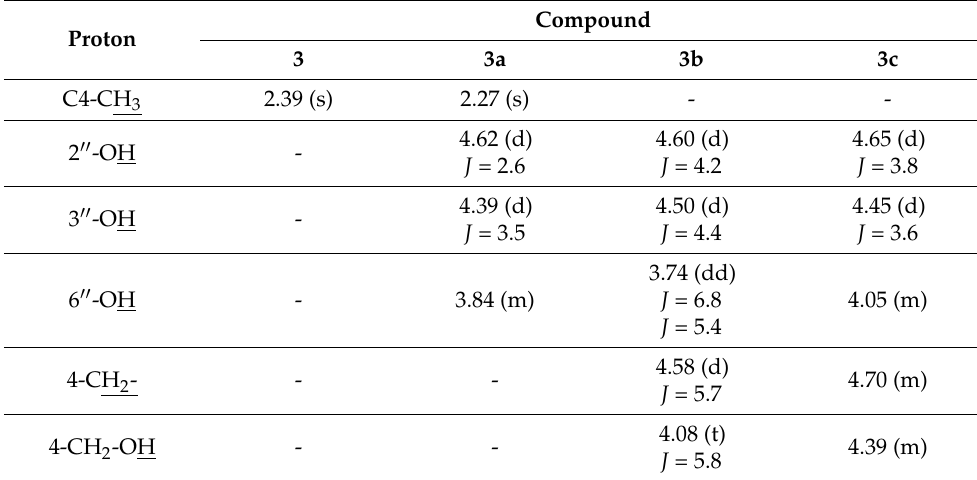
13 C-NMR chemical shifts δ (ppm) and coupling constants J (Hz) of 2 (cid:48) -hydroxy- 4-methylchalcone ( 3 ) and products of its biotransformation 3a – 3c in Acetone-d6, 151 MHz (Supplementary Materials: Figures S4, S5, S25–S27, S50–S52 and S74–S76).